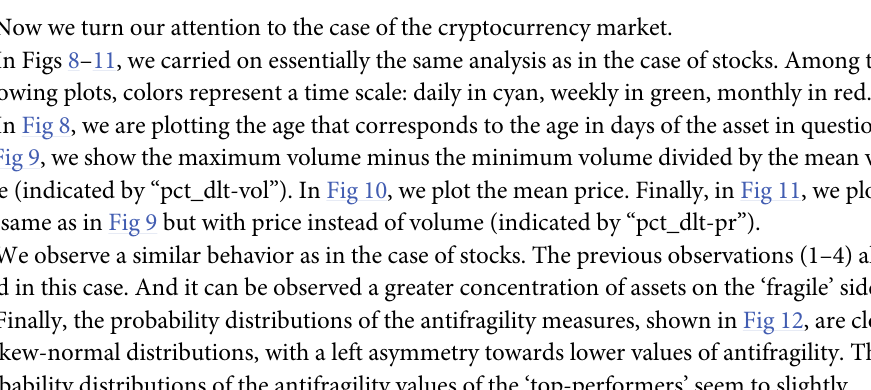
Fig 3. Comparison of antifragility values and age in stocks. Each subplot corresponds to a timescale (daily in cyan, weekly in green, monthly in red, semiannual in yellow). The plots compare the antifragility A measure (in the x -axis) to the corresponding ‘good-performance’. We observe how higher values of the ‘good-performance’ measure concentrate in the robust axis A = 0 . See the text for details of this figure.